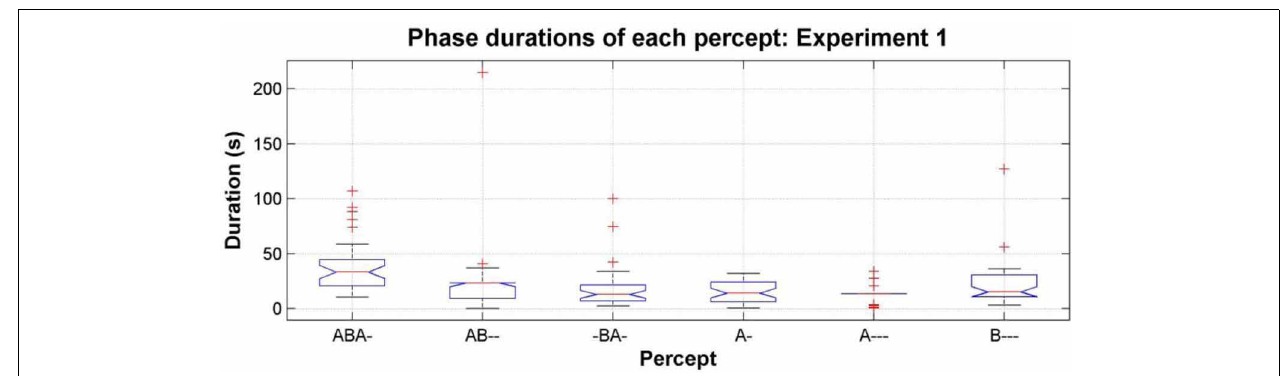
FIGURE 6 | Phase durations of each pattern, pooling the data from all participants, all sessions and all conditions in experiment 1; see Figure 4 for figure conventions.